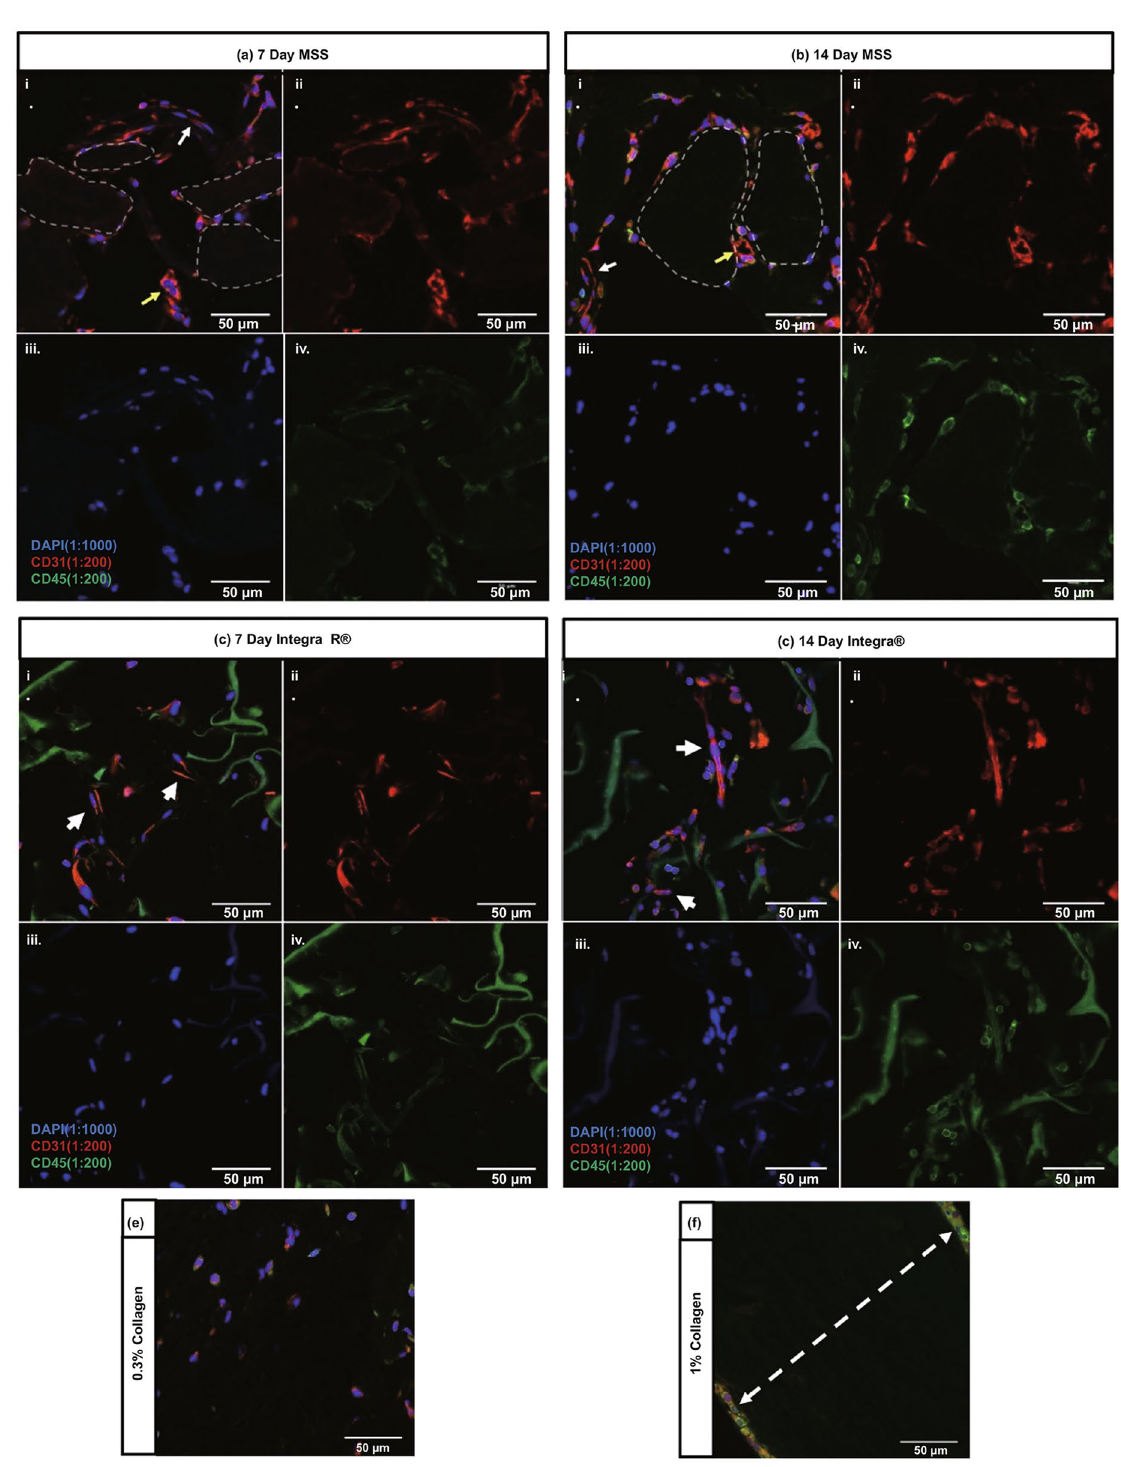
Fig. 9 In vivo phases on the neovascularization’s experiments; a CD31 and CD45 stainings of microsphere scaffolds; b endothelial cell stain- ings of microsphere scaffolds; c , d endothelial cell stainings of Integra® scaffolds; e , f CD31 and CD45 stainings of type I collagen scaffolds